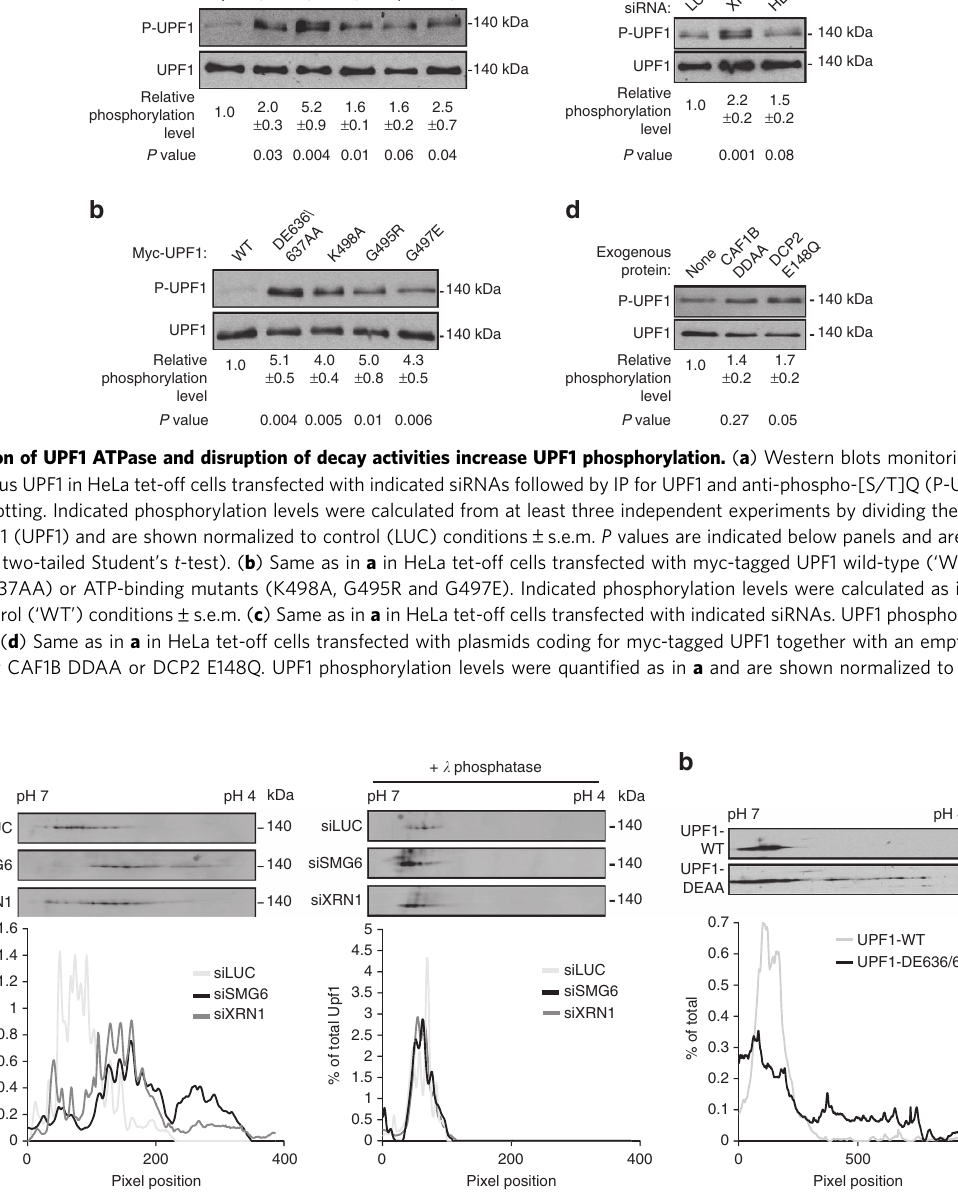
of phosphorylations or the extent of phosphorylation at individual sites, the observed change in UPF1 isoelectric points is due to UPF1 hyperphosphorylation as treatment with l phosphatase collapsed the signal and generated UPF1 profiles for SMG6 and XRN1 siRNA-treated cells that were indistinguishable